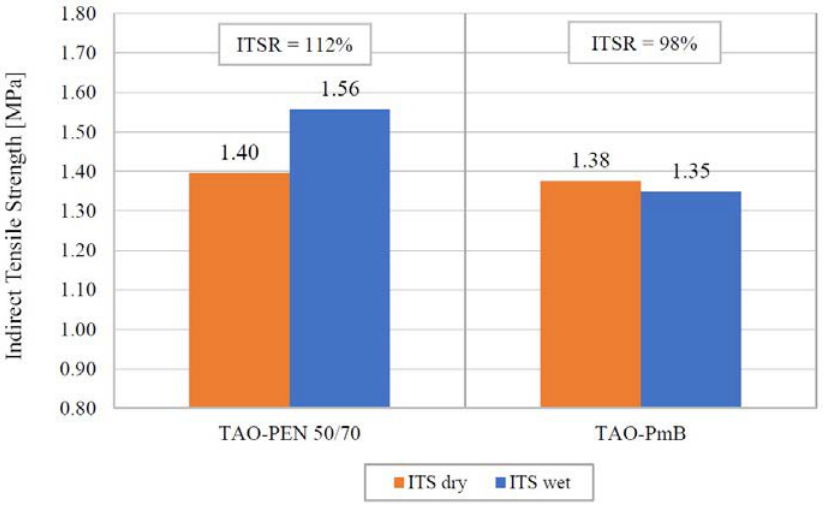
Figure 6. Average ITSR data from the ITS values at dry and wet conditioning of TAO–PEN 50/70 and TAO–PmB.